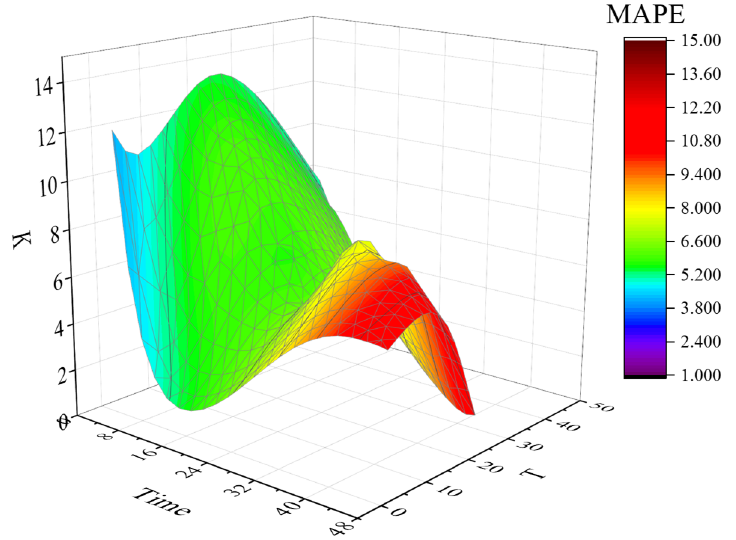
Figure 5. The corresponding relationship between T value, K value and MAPE value at different times.